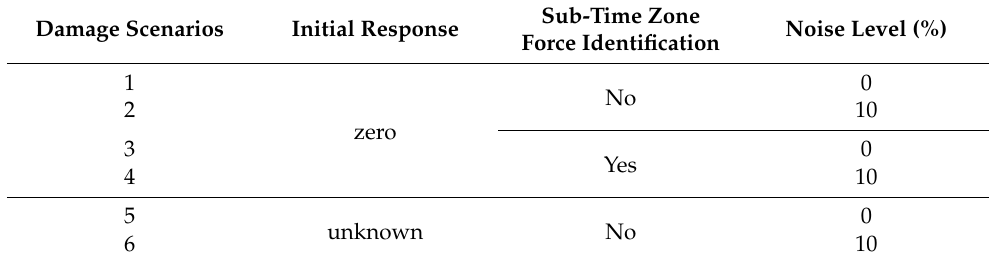
Table 1. Damage scenarios.